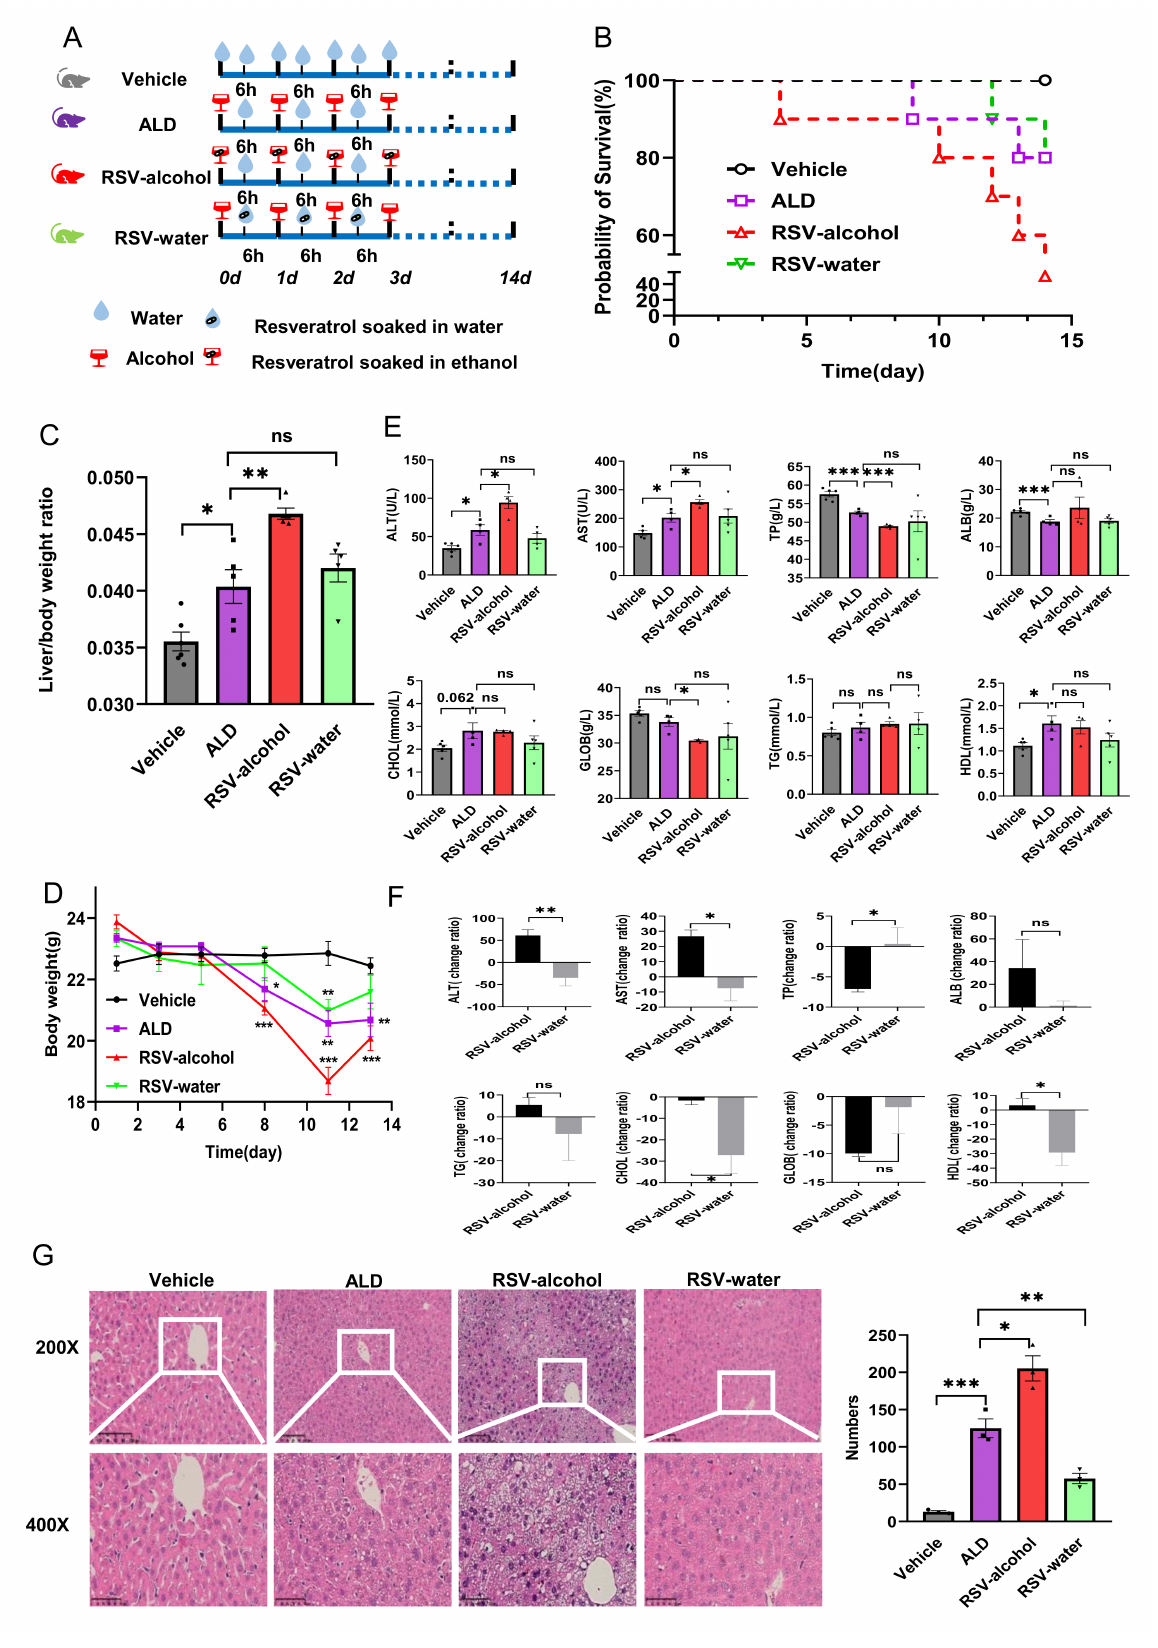
Figure 1. The RSV-alcohol combination worsened ALD in mice and reduced the efficacy of RSV. ( A ) Model ALD mice and mimicking the habit of herbal wine used to treat RSV. ( B ) Comparison